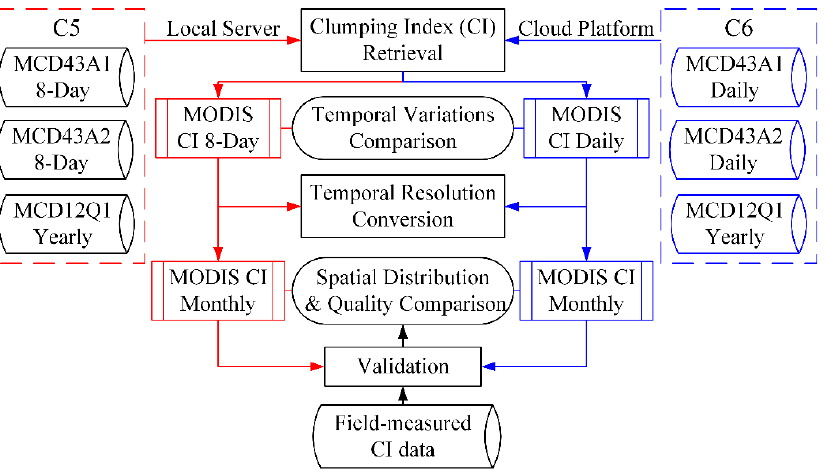
Figure 2. Flow chart of the comparison of CI retrievals using two versions of MODIS BRDF products between C5 (red rectangles) and C6 (blue rectangles).